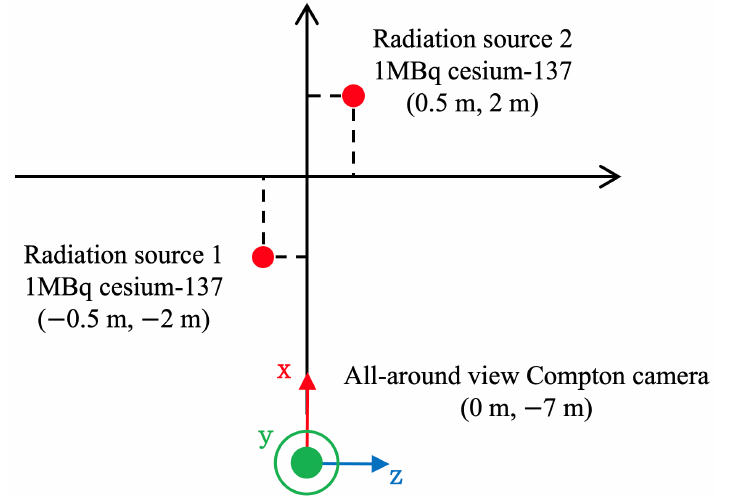
Figure 13. Simulation condition in which multiple radiation sources were dispersed: two radiation sources were positioned in two locations: ( − 0.5 m, − 2 m) and (0.5 m, 2 m). Cesium-137 (1 MBq) was adopted as the radiation source. The robot was positioned 7m from the origin of the